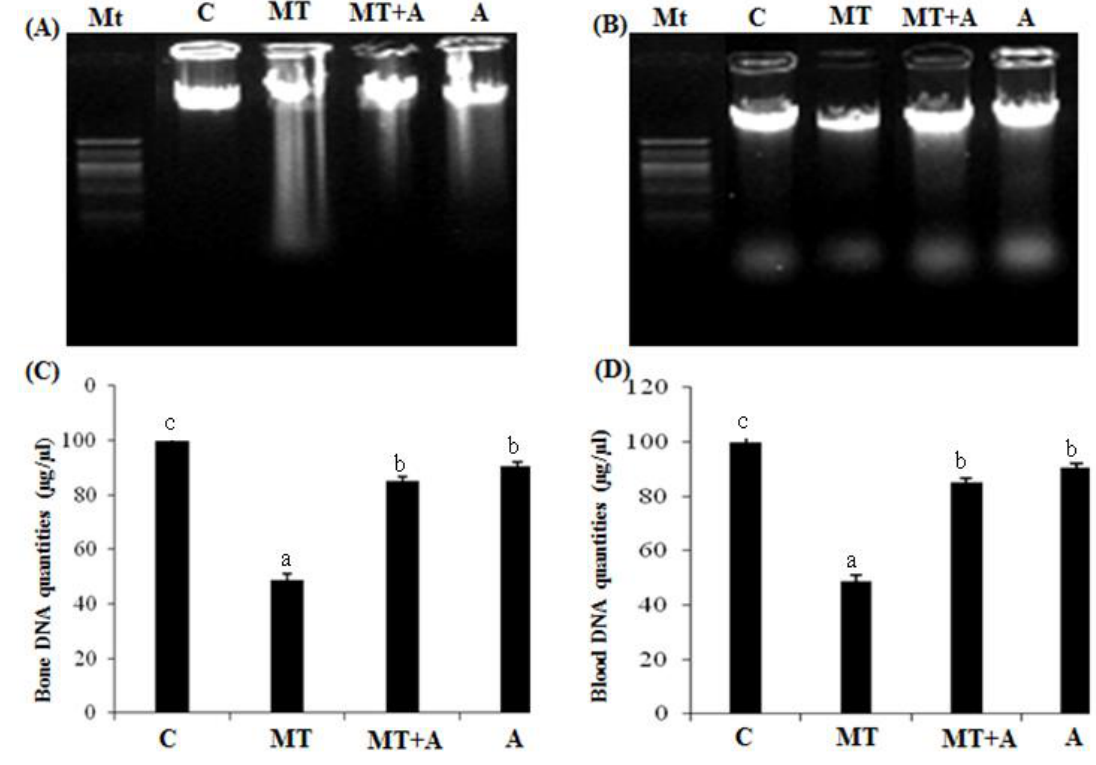
Figure 8. ( A ) Agarose gel electrophoresis of the bone DNA fragmentation. MT, marker (1 kb DNA ladder); lane 1, controls group; lane 2, MT treated group (MT); lane 3, MT + FRE-treated group (MT + A); lane 4, FRE-treated group; ( B ) Agarose gel electrophoresis of the WBCs DNA fragmentation. MT, marker (1 kb DNA ladder); lane 1, control group (C); lane 2, MT treated group (MT); lane 3, MT + FRE-treated group (MT + A); lane 4, FRE-treated group (A); ( C ) Bone DNA quantities of controls (C) and rats treated with MT (MT), MT + FRE (MT + A), and FRE (A) after 7 days; ( D ) Bloob DNA quantitie controls s of (C) and rats treated with MT (MT), MT + FRE (MT + A), and FRE (A) after 7 days. a,b,c indicate significant differences between experimental groups ( p < 0.05).